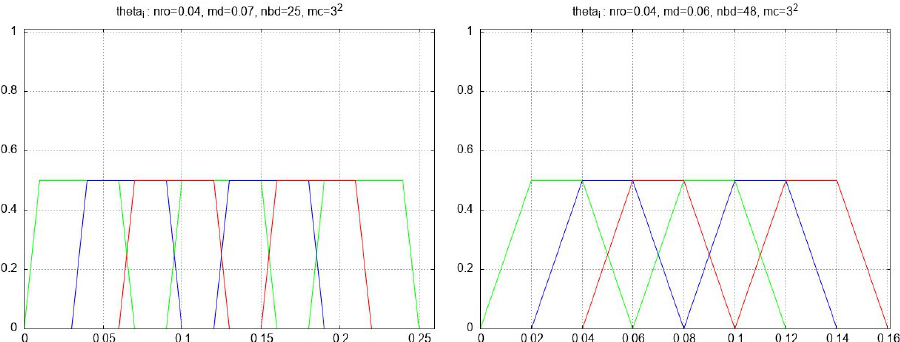
Figure 8. Sections in the direction of a coordinate axis passing through the center of the functions of a unity partition: 25 2 subdomains ( left ) and 48 2 subdomains ( right